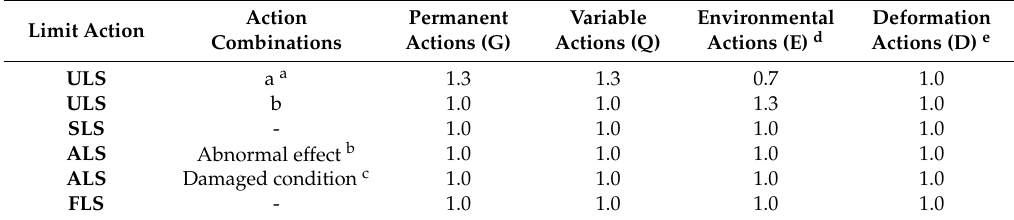
Table 12. Load and Resistance Factors of Load and Resistance Factor Design (LRFD).